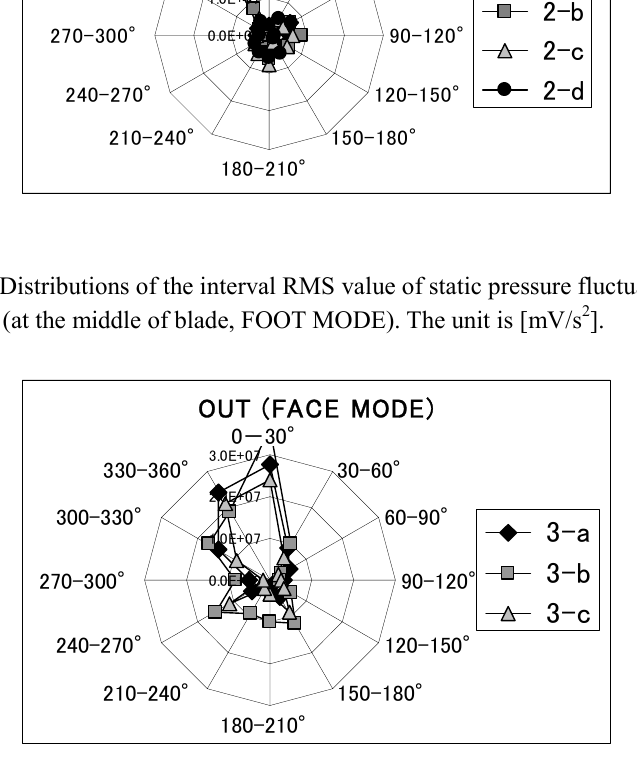
Fig. 15 Distributions of the interval RMS value of static pressure fluctuation (at the outlet of blade, FACE MODE). The unit is [mV/s 2 ].